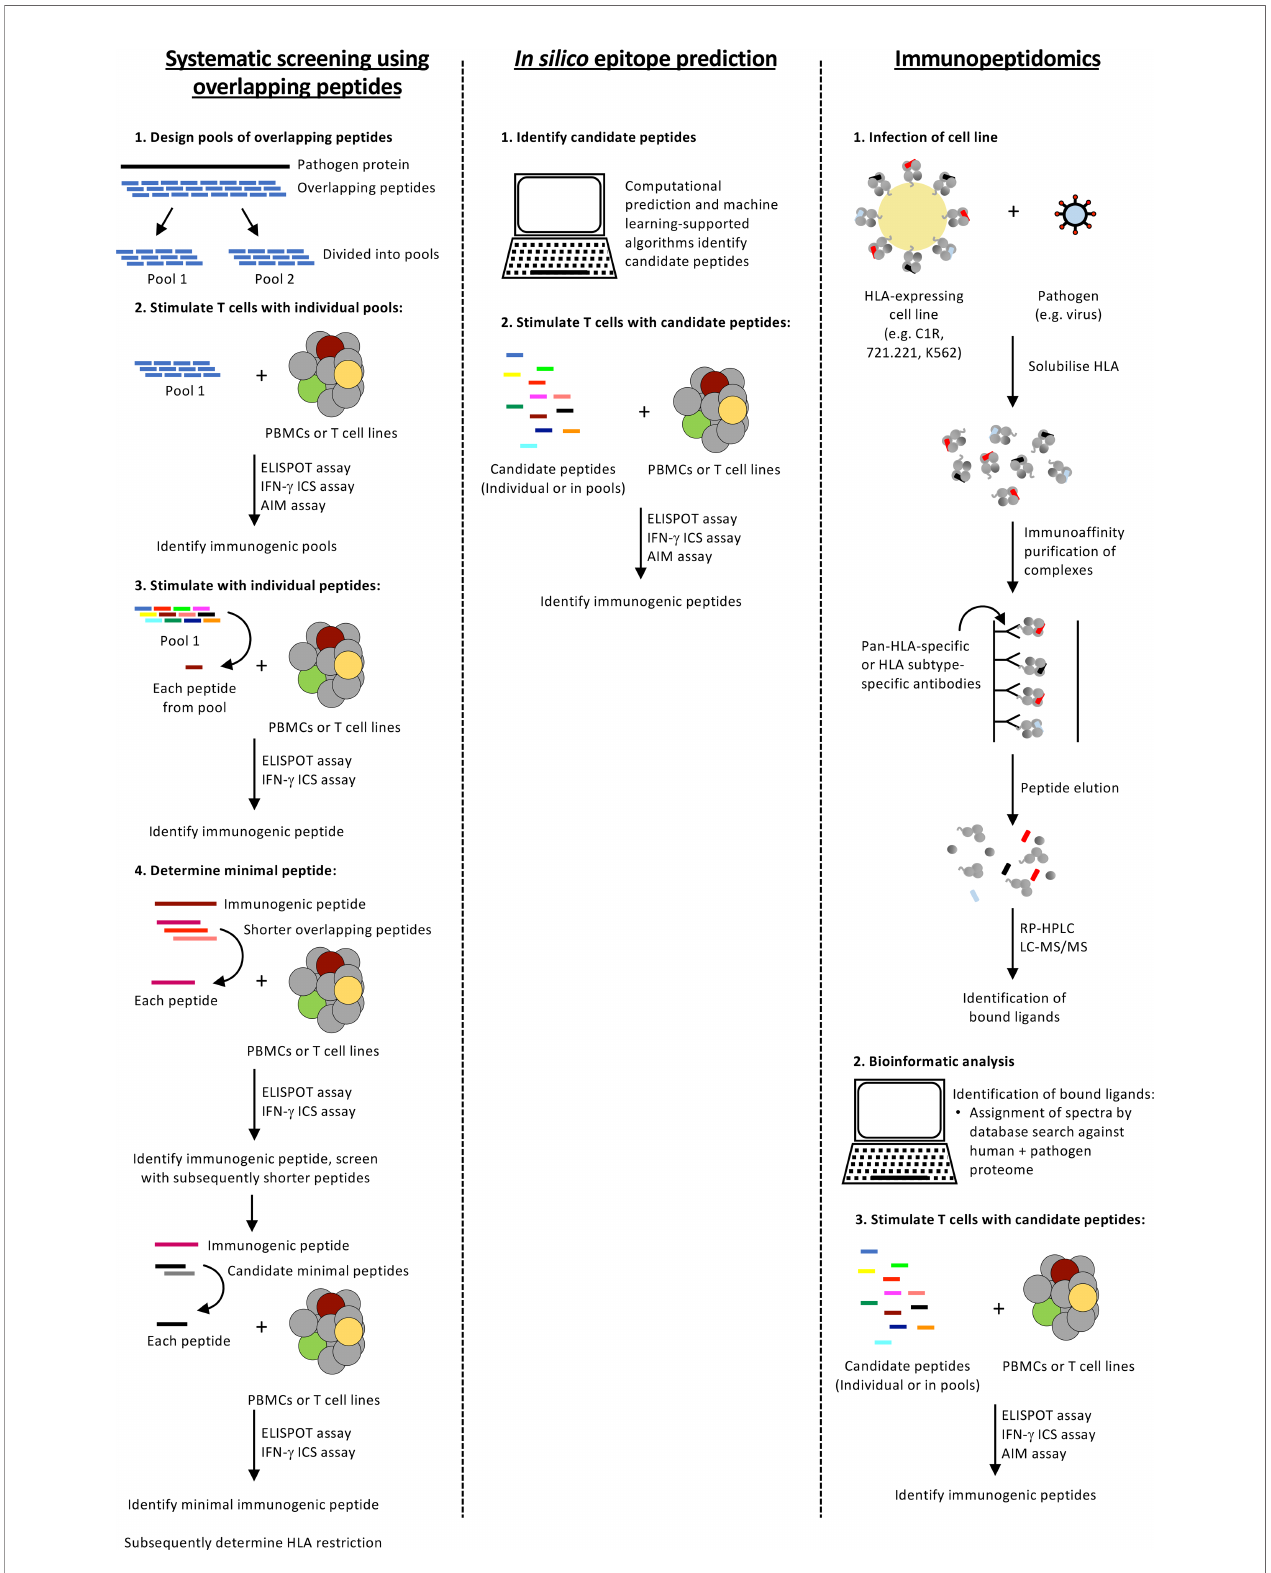
FIGURE 2 | Approaches for identifying T cell epitopes for HLA alleles expressed by Indigenous populations. A summary of three epitope identi fi cation